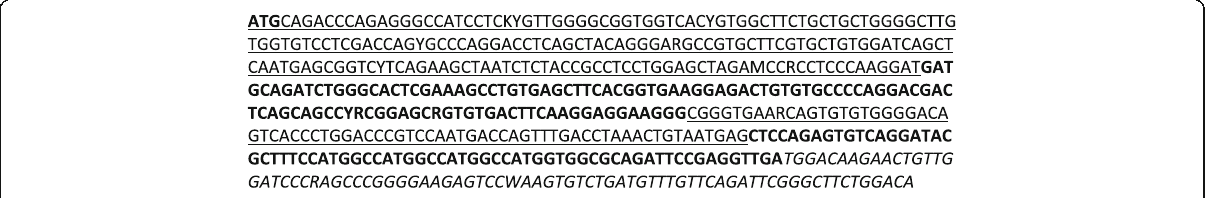
Fig. 1 Buffalo CATH4 full-spliced cDNA sequence. Exons 1 and 3 are underlined, and 2 and 4 are in bold. 3 ′ Untranslated region is in italic. SNPs: M (A/C), R (G/A), K (T/G), Y(C/T), and W